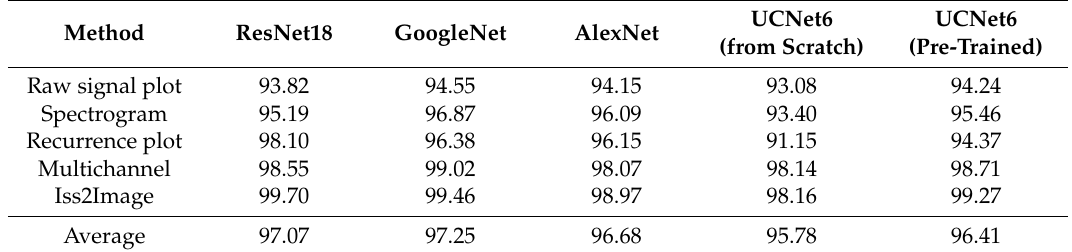
Table 5. Recognition accuracy (%) comparison of different transformation methods on different